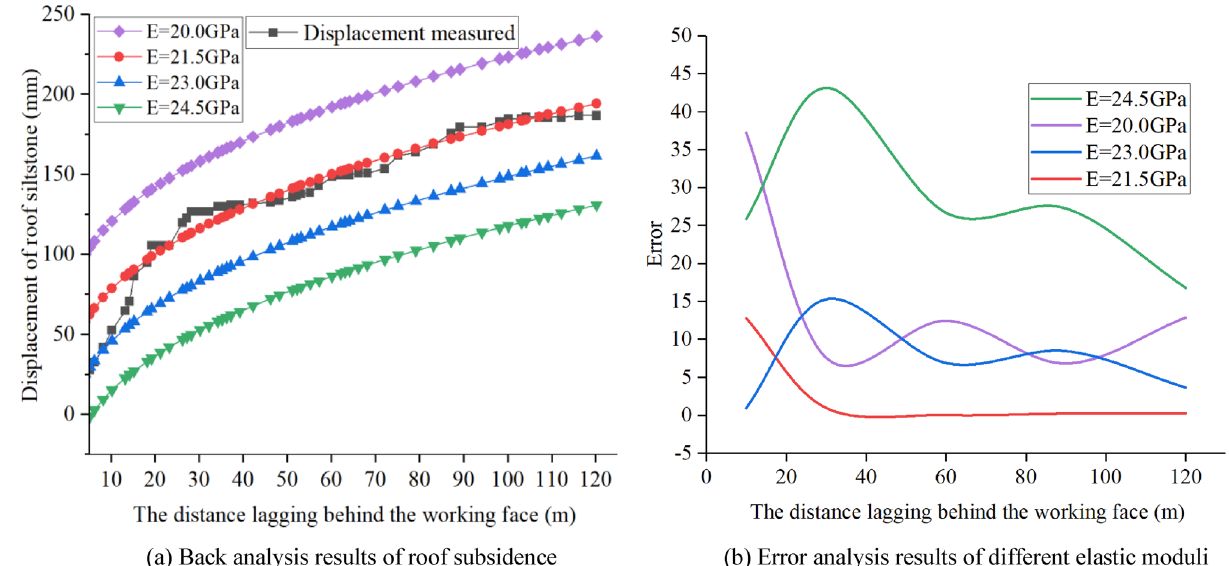
Figure 10. Calibration of elastic modulus of post stone in floor.